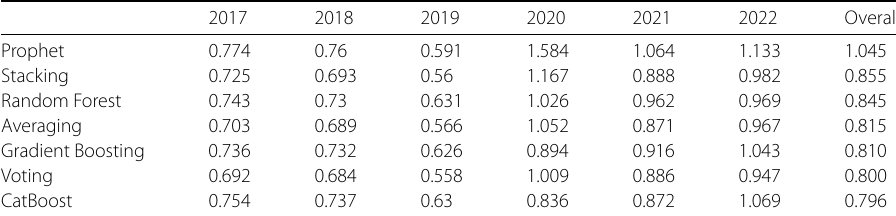
Table 11 TheilU Statistic for Clinic